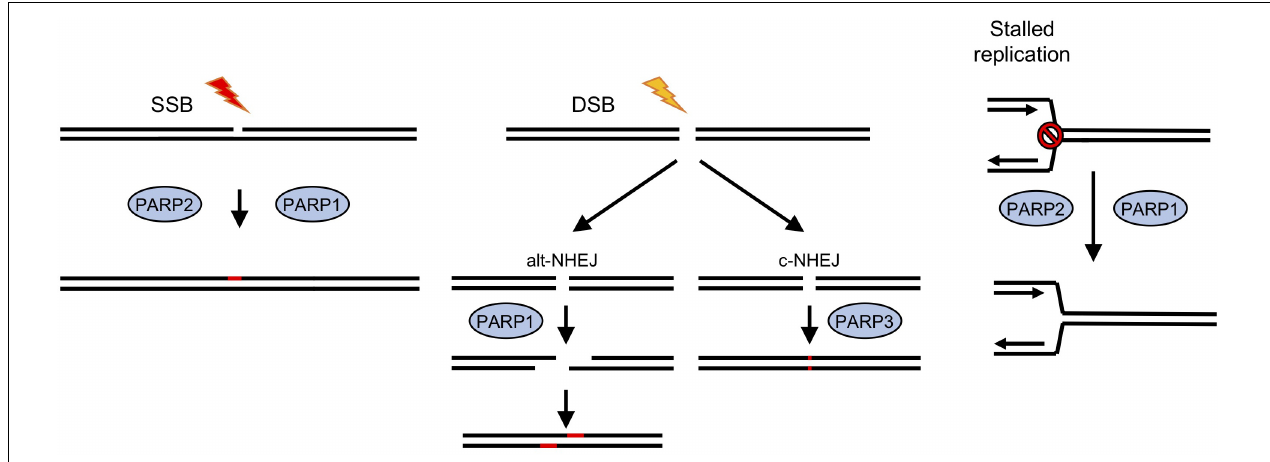
FIGURE 1 | Roles for ADP-ribosyl transferases in strand break repair in human cells. In human cells PARPS have a well-established role in DNA repair (Caldecott, 2014; Azarm and Smith, 2020). PARPs 1 and 2 have been implicated in repair of single strand breaks (SSB), which are induced either directly by exogenous or endogenous damaging agents, or as a result of base excision repair (BER) pathways following base damage. Recruitment of PARPs1/2 to the break site and subsequent ADP-ribosylation of proteins, including histones at the damage site, lead to recruitment or stabilization of repair factors and subsequent damage resolution. DNA double strand break (DSB) repair by classical non-homologous end joining (c-NHEJ) involves a third PARP, PARP3, whereas an alternative version (alt-NHEJ) is dependent on PARP1. Stalled replication forks can lead to fork collapse and restart is also thought to be PARP-dependent.